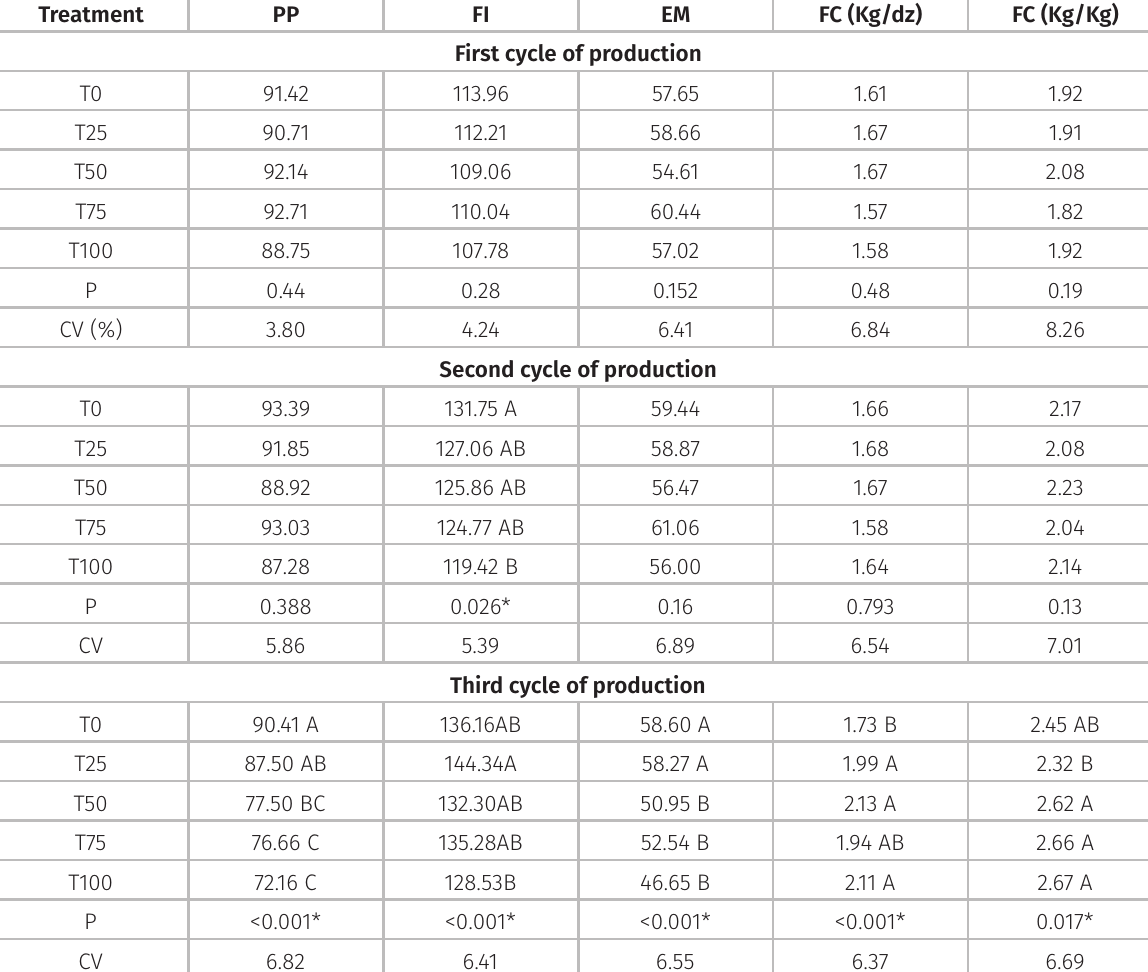
Table V. Production percentage averages (PP), feed intake (FI, g/hen/day), egg mass (EM, g/hen/day) and feed conversion (FC, Kg/dz and kg/kg) of the hens that received the different levels of industrial egg residue in the diet to replace calcitic limestone in the first, second and third production